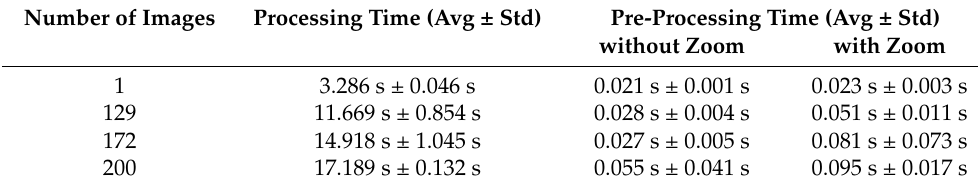
Table 3. Processing and pre-processing times for different sets of